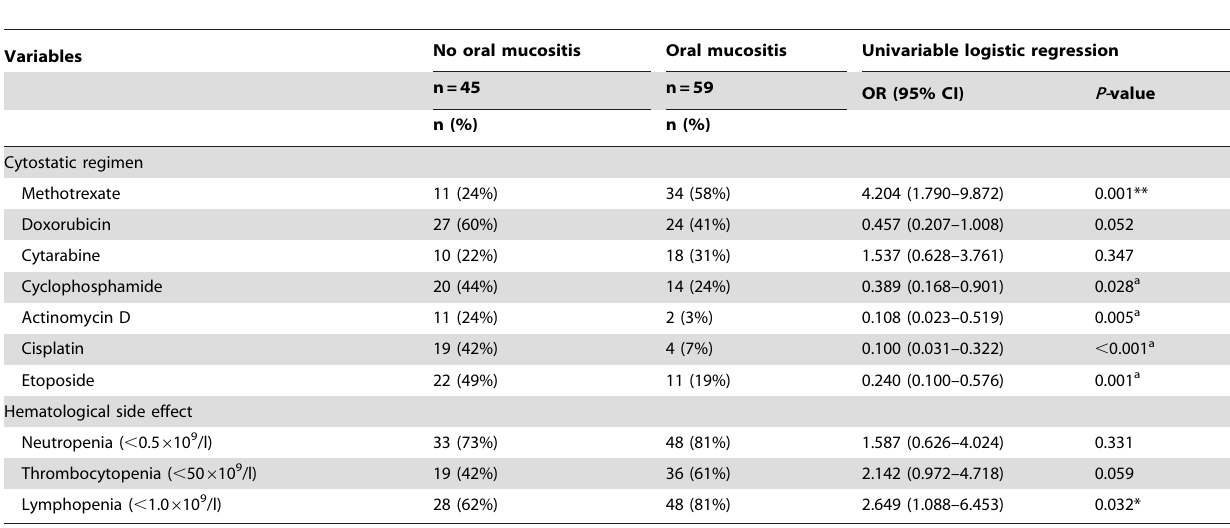
Table 3. Univariable logistic regression with treatment-related factors during chemotherapy as independent variables and oral mucositis as the outcome in all patients (n=104).